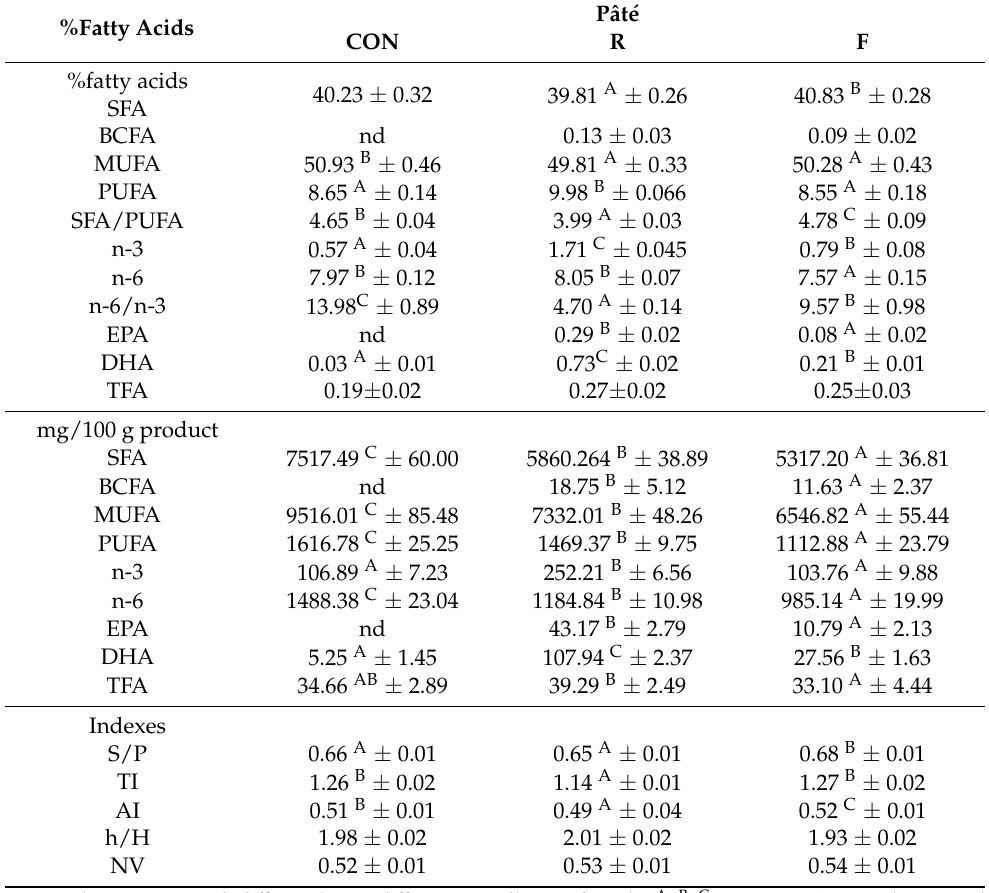
Table 5. Fatty acid profile (% fatty acids) and content (mg/100 g product) of pork p â t é s (mean ± s.d.). %Fatty